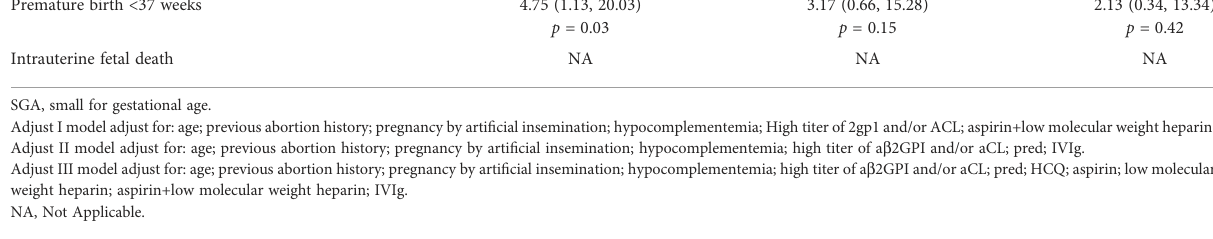
TABLE 4 Medication treatment changed the adverse pregnancy outcomes in APS patients with thrombocytopenia in fi rst-trimester. Thrombocytopenia in fi rst-trimester